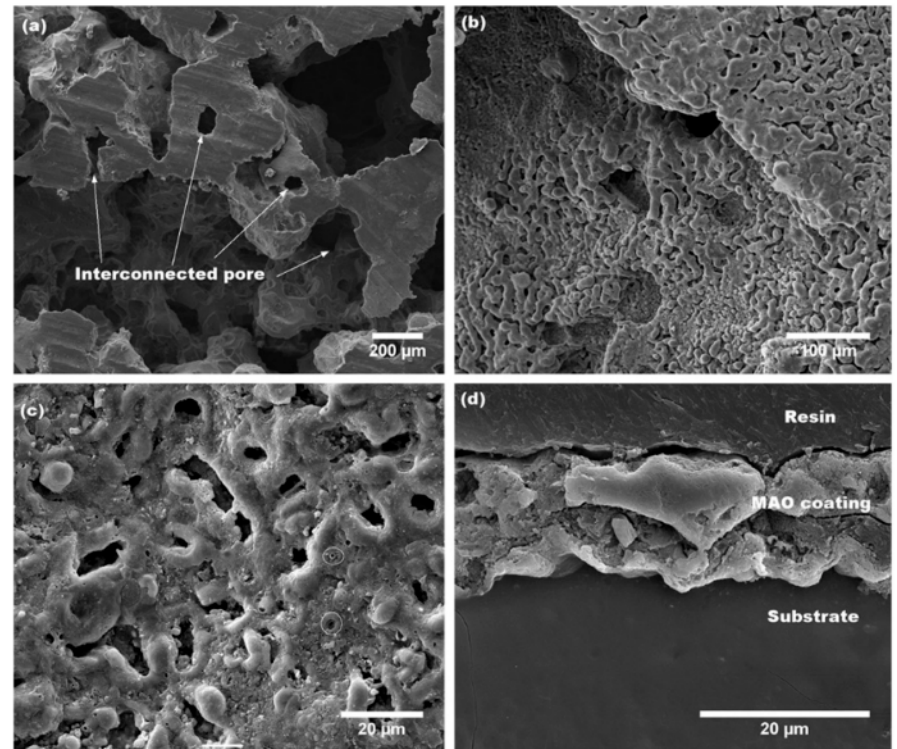
Figure 15. SEM images of ( a ) the uncoated magnesium foam, ( b , c ) the surface of the MAO-coated AZ31 Mg foam, and ( d ) the cross-section of the MAO-coated AZ31 Mg foam. Reprinted from Reference [106] with permission from Elsevier.